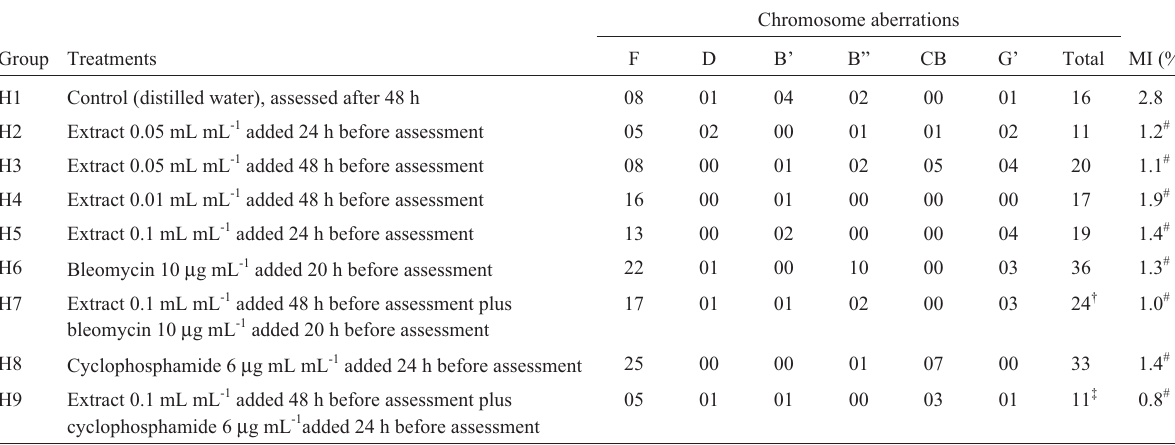
Table 2 - Number of chromosome aberrations and percentage mitotic index (MI) recorded in Chinese hamster ovary cells (CHO-K1) subjected to differ- ent in vitro treatments and treatment times with Caryocar brasiliense (pequi) aqueous extract, with or without the clastogens cyclophosphamide and bleomycin. Aliquots of the extracts were sterilized using a Millipore 0.2 mm nitrocellulose membrane before addition to the medium. Significant differ- encesbytheMann-Whitney U testareshownforthetotalaberrationsandthepercentageMI.Aberrationkey:F=fragment;D=dicentric;B’=chromatid break; B” = chromosome break; CB = centromere break; and G’ = chromatid gap. Chromosome aberrations